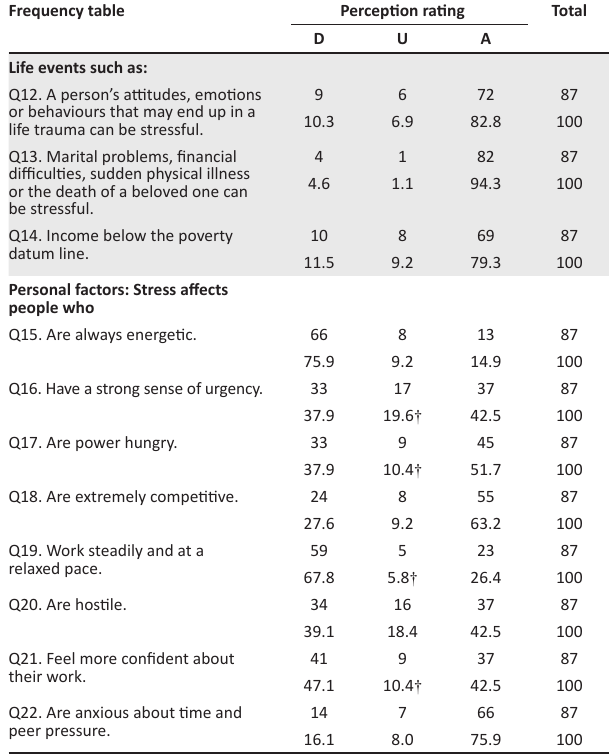
TABLE 2: Effects of stress on life events and personal factors ( n = 87). Frequency table